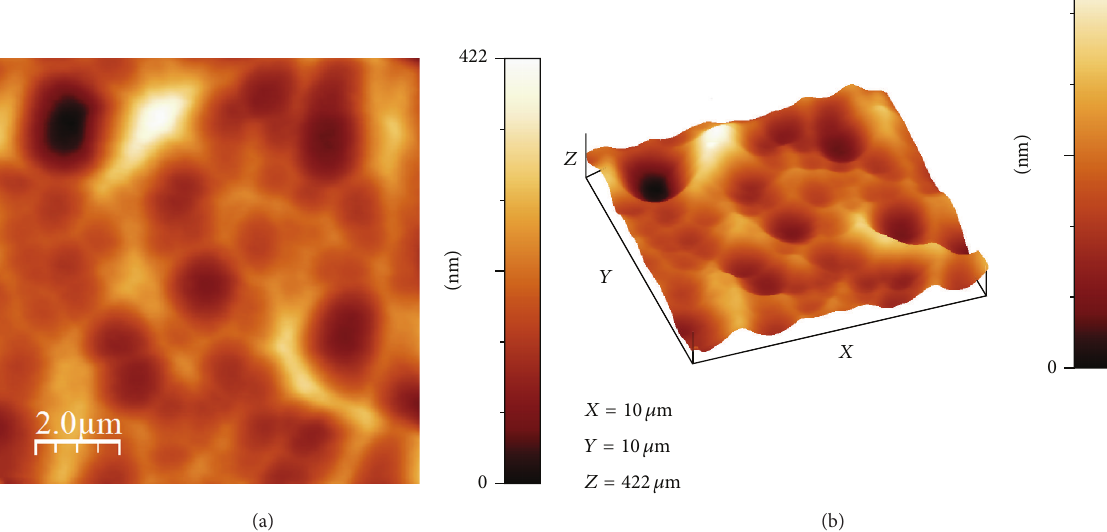
Figure 1: AFM image of the AIT sample after TCO deposition. (a) is the 2D top view and (b) is the 3D projection of the AFM measurement. The 𝑧 -axis scale is not proportional to the scales of the 𝑥 - and 𝑦